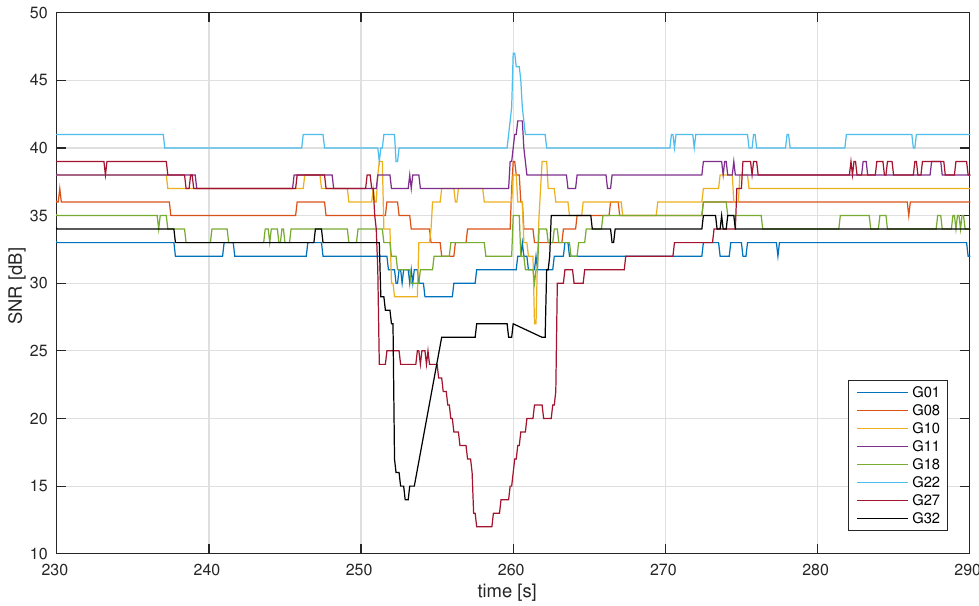
Figure 7. Tracked satellites of Receiver 2 during the static experiment: eight satellites are tracked; the SNR of Satellites G27 and G32 drops below 28dB at t ≈